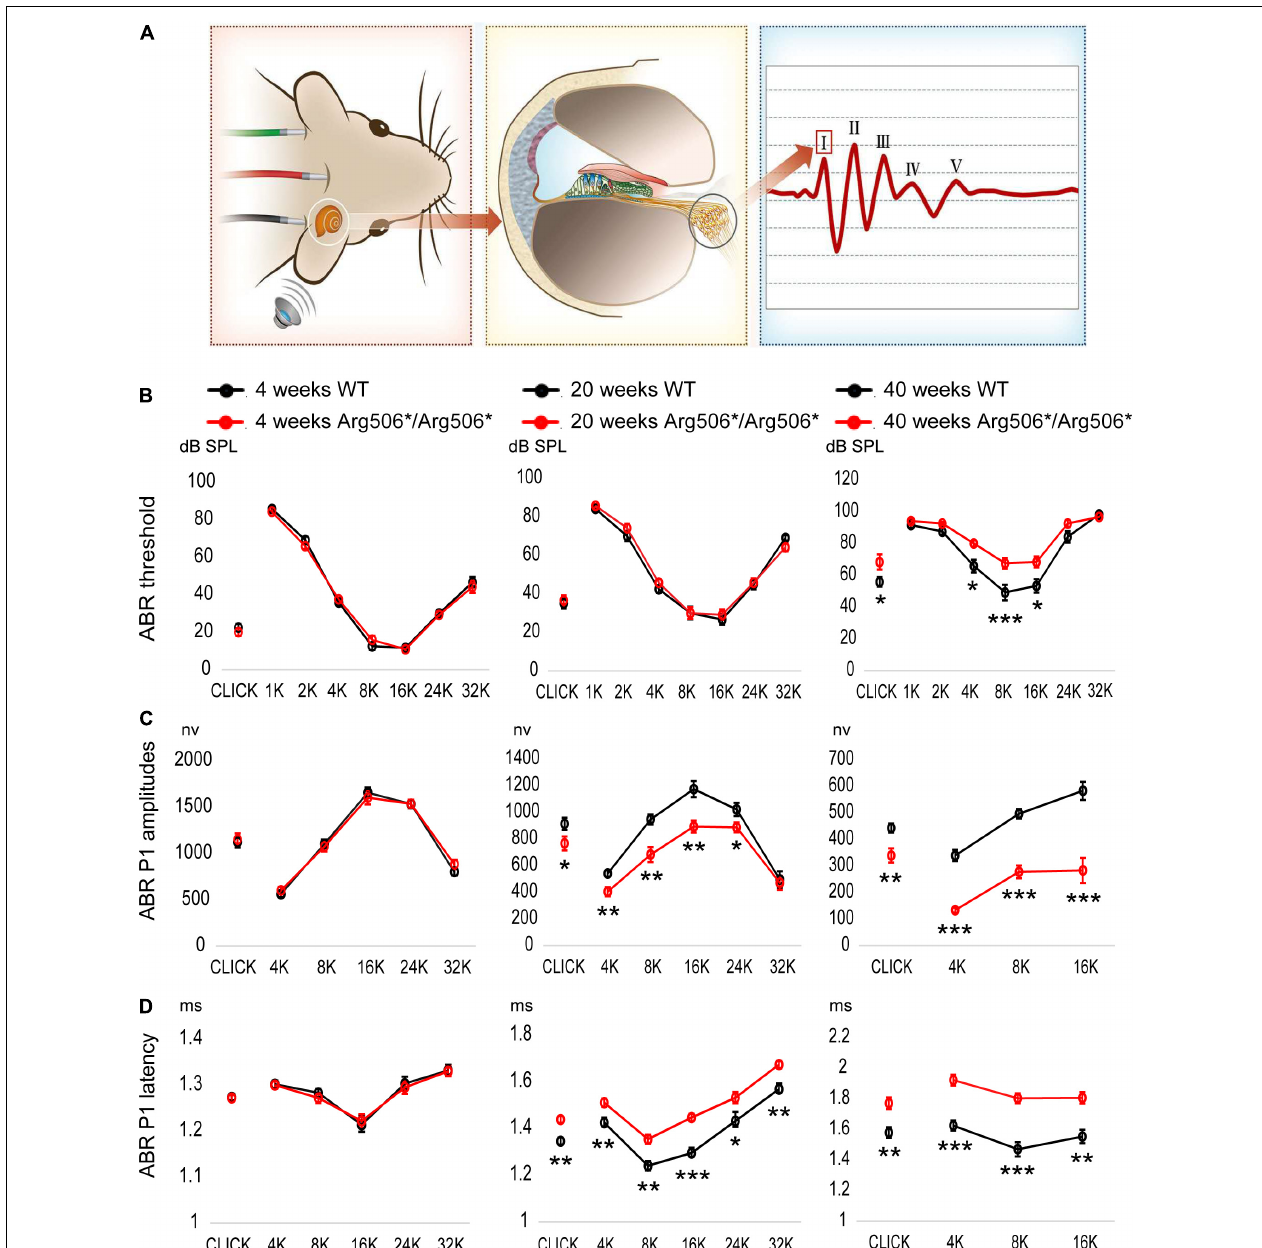
FIGURE 1 | Progressive hearing impairment with increasing age in Atp6v1b2 Arg 506 ∗ / Arg 506 ∗ mice. (A) Auditory brainstem responses (ABR) were recorded to evaluate the hearing in mice. After acoustic stimulation, the recording electrode recorded five waveforms, of which peak I (P1) was derived from spiral ganglion neurons in the mouse cochlea. The hearing thresholds were defined as the lowest sound intensity that elicited identifiable waves. (B) ABR thresholds (shown in ordinate) to click and to 1, 2, 4, 8, 16, 24, and 32 kHz (shown in abscissa) tone-burst stimuli were compared between WT and Atp6v1b2 Arg 506 ∗ / Arg 506 ∗ mice. At 4 weeks and 20 weeks, ABR thresholds showed no significant difference between WT and Atp6v1b2 Arg 506 ∗ / Arg 506 ∗ mice. At 40 weeks, ABR thresholds to click and to 4, 8, and 16 kHz stimuli were significantly higher in Atp6v1b2 Arg 506 ∗ / Arg 506 ∗ than in WT mice. (C) ABR P1 amplitudes (shown in ordinate) were compared between WT and Atp6v1b2 Arg 506 ∗ / Arg 506 ∗ mice. There was no significant difference at 4 weeks. At 20 weeks, Atp6v1b2 Arg 506 ∗ / Arg 506 ∗ mice had significantly lower peaks to click and to 4, 8, 16, and 24 kHz tone-burst stimuli than WT mice. At 40 weeks, Atp6v1b2 Arg 506 ∗ / Arg 506 ∗ mice had significantly lower peaks to click and to 4, 8, and 16 kHz tone-burst stimuli than WT mice. (D) ABR P1 latencies (shown in ordinate) stimulated by different sound types (shown in abscissa) with the same sound intensity (90 dB SPL) were compared between WT and Atp6v1b2 Arg 506 ∗ / Arg 506 ∗ mice. There was no significant difference at 4 weeks. At 20 weeks, Atp6v1b2 Arg 506 ∗ / Arg 506 ∗ mice showed significantly longer latencies to click and to 4, 8, 16, 24 and 32 kHz tone-burst stimuli than WT mice. At 40 weeks, Atp6v1b2 Arg 506 ∗ / Arg 506 ∗ mice showed significantly longer latencies to click and to 4, 8, and 16 kHz tone-burst stimuli than WT mice. The t -test was performed to evaluate statistical significance; n represents the number of test ears, n = 6 for each group; * denotes P < 0.05, ** denotes P < 0.01, *** denotes P < 0.001. Data are described as mean + SEM (standard error of mean).